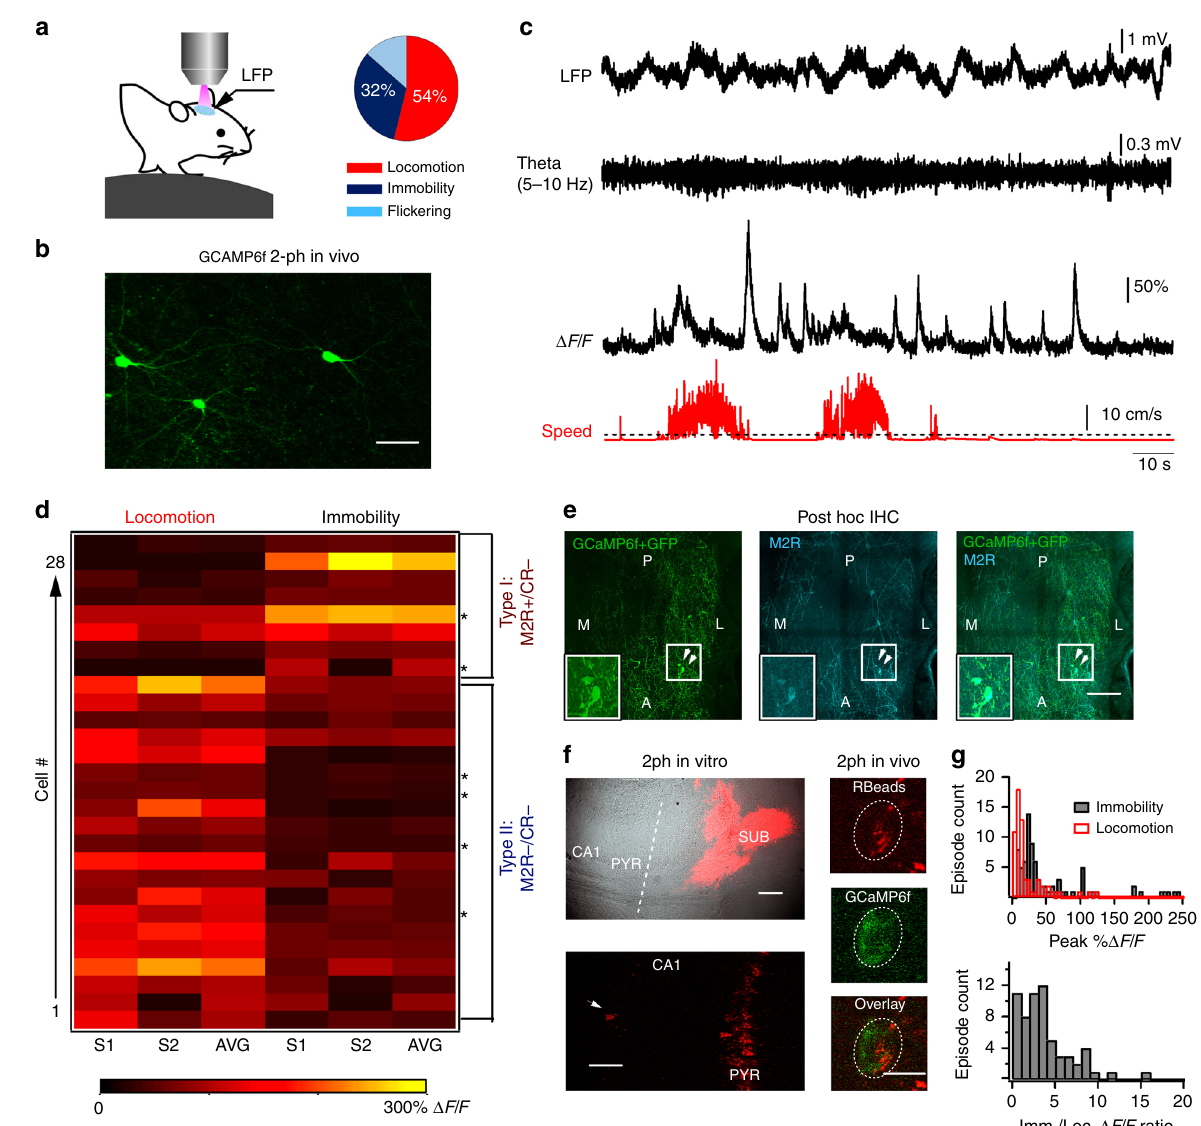
Fig. 5 Imaging VIP-LRP activity in awake mice. a Schematic of two-photon Ca 2 + -imaging and LFP recordings in awake mice (left) and a pie-chart illustrating the time distribution of animal activity (right). b Two-photon image of the GCaMP6f-expressing VIP cells in CA1 O/A (maximal projection of a 100- µ m Z- stack). Scale bar: 50 µ m. c Representative traces of simultaneous LFP recording (upper raw trace and fi ltered for theta: 5 – 10 Hz), somatic Ca 2 + -imaging from a VIP cell, and animal speed (red). d VIP O/A cell segregation based on the peak Ca 2 + -transient during locomotion and immobility. Two types of neurons were revealed: type I VIP cells ( n = 8) were positive for M2R and negative for CR (2 out of 2 cells tested indicated with stars) whereas type II VIP- expressing cells ( n = 20) were negative for both M2R and CR (4 out of 4 cells tested). S1 and S2 represent two imaging sessions and AVG is the average peak Ca 2 + -signal during two sessions. e Confocal stitching of the CA1 O/A imaging window used for two-photon image acquisition in vivo and processed for post hoc immunohistochemistry illustrating GFP (left), M2R (middle) and the overlay of the two (right). White arrowheads point to M2R-positive VIP cells targeted with GCaMP6f (expanded in insets). Anatomical landmarks are indicated as follows: A — anterior, P — posterior, M — medial, L — lateral. Scale bar: 100 µ m. f Representative two-photon images obtained from hippocampal slices of VIP-Cre mice in vitro (left) and from the CA1 O/A VIP + interneuron in vivo (right) illustrating the RetroBead injection site in SUB (left top, Dodt image superimposed with epi fl uorescence image for Retrobeads), the retrogradely labelled CA1 PCs and an O/A interneuron (white arrow; left bottom) and a CA1 O/A VIP-LRP labelled with RetroBeads and expressing GCaMP6f (right). Scale bars: 500 µ m (top), 50 µ m (bottom left), 10 µ m (bottom right). g Histograms of Ca 2 + -transient peak amplitude (top) and its ratio during immobility to that during locomotion (bottom) obtained from VIP-LRPs labelled with RetroBeads ( n = 5 cells, 25 – 30 locomotion/immobility periods/cell) and showing a larger amplitude of Ca 2 + -signals during immobility than during locomotion ( p < 0.01, one-way ANOVA/Tukey ’ s using a combinatorial VIP-LRP targeting via injection of retro- VIP + SUB-projecting neurons. With both strategies, prior cali- grade Cav2- Cre into SUB of VIP- fl p;Ai65 mice (Fig. 7a, c). The bration experiments were performed to control for the virus reporter Ai65D (B6;129S-Gt(ROSA)26Sortm65.1(CAG-tdTo- spread from SUB to CA1 (Fig. 7a; see Methods for details). In mato)Hze/J) mouse line expresses tdTomato under the control of addition to a small population of local SUB VIP + cells (Fig. 7b, cre and fl p . Crossing this reporter line with VIP- fl p mice and left), CA1 VIP + interneurons with somata located within O/A, injecting the Cav2- Cre in the SUB allows selective targeting of PYR, RAD or LM were sparsely labelled ( VIP-Cre;Ai9 mice +